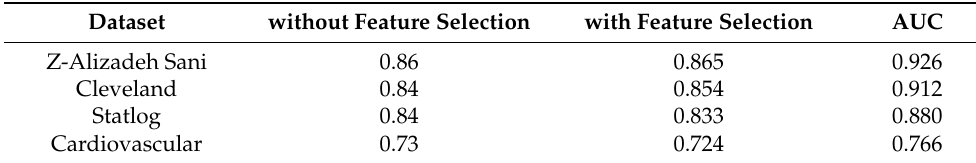
Table 5. Performance accuracy using the random forest classification.